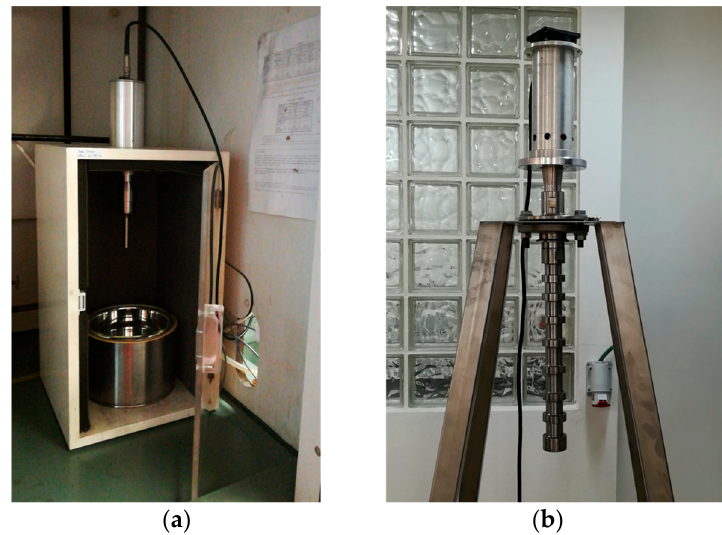
Figure 2. Probes used for the ultrasound-assisted extraction at: ( a ) lab scale; ( b ) pilot scale.